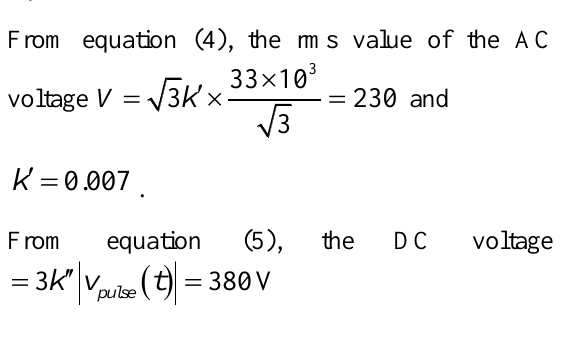
Figure 9: Voltage at different